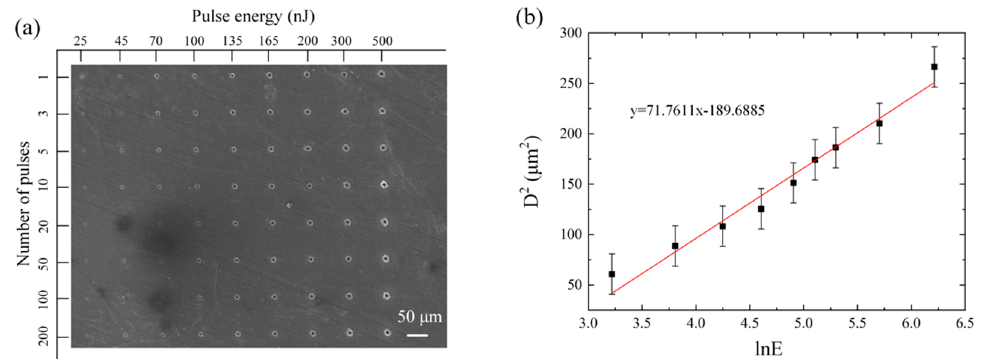
Figure 2. ( a ) SEM image of carbon nanotube (CNT) film ablated by different laser pulse energies and number of pulses and ( b ) plot of the diameter square of the produced craters changing with the logarithm of pulse energy.